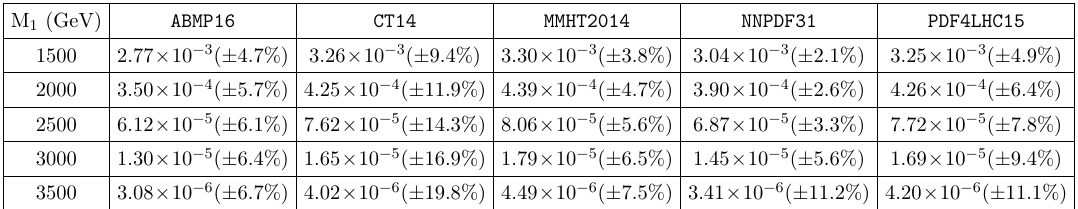
Table 6 . Intrinsic PDF uncertainties in the signal at NNLO+NNLL QCD for di(cid:11)erent PDF choices are given right at the resonance for di(cid:11)erent M 1 values. All the results are presented for 13 TeV LHC. The cross sections are given in terms of pb for the central set ( n = 0) for each PDF group along with the corresponding intrinsic uncertainties in terms of the